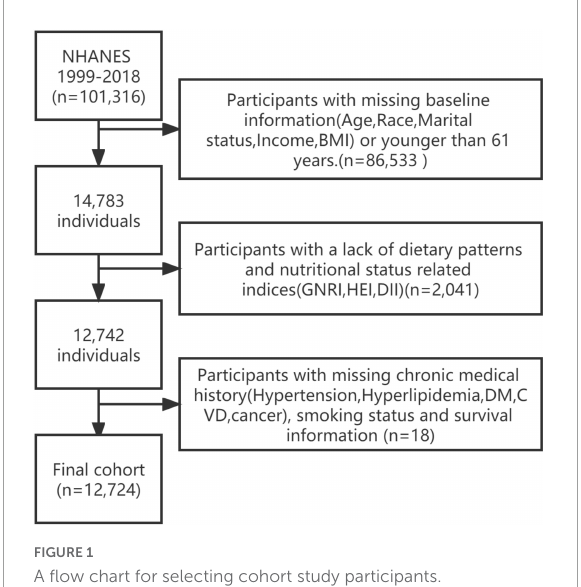
FIGURE1 A flow chart for selecting cohort study